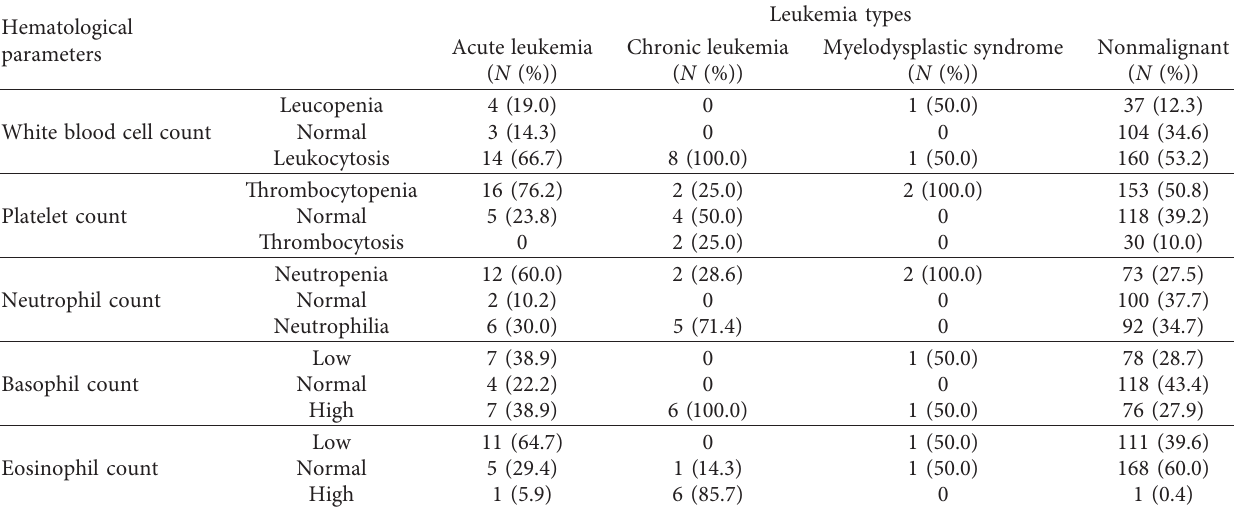
Table 2: Distribution of hematological parameters counts for leukemia type of patients who have abnormal hematological parameters in JMC from January 1, 2019, to April 30, 2019. Hematological